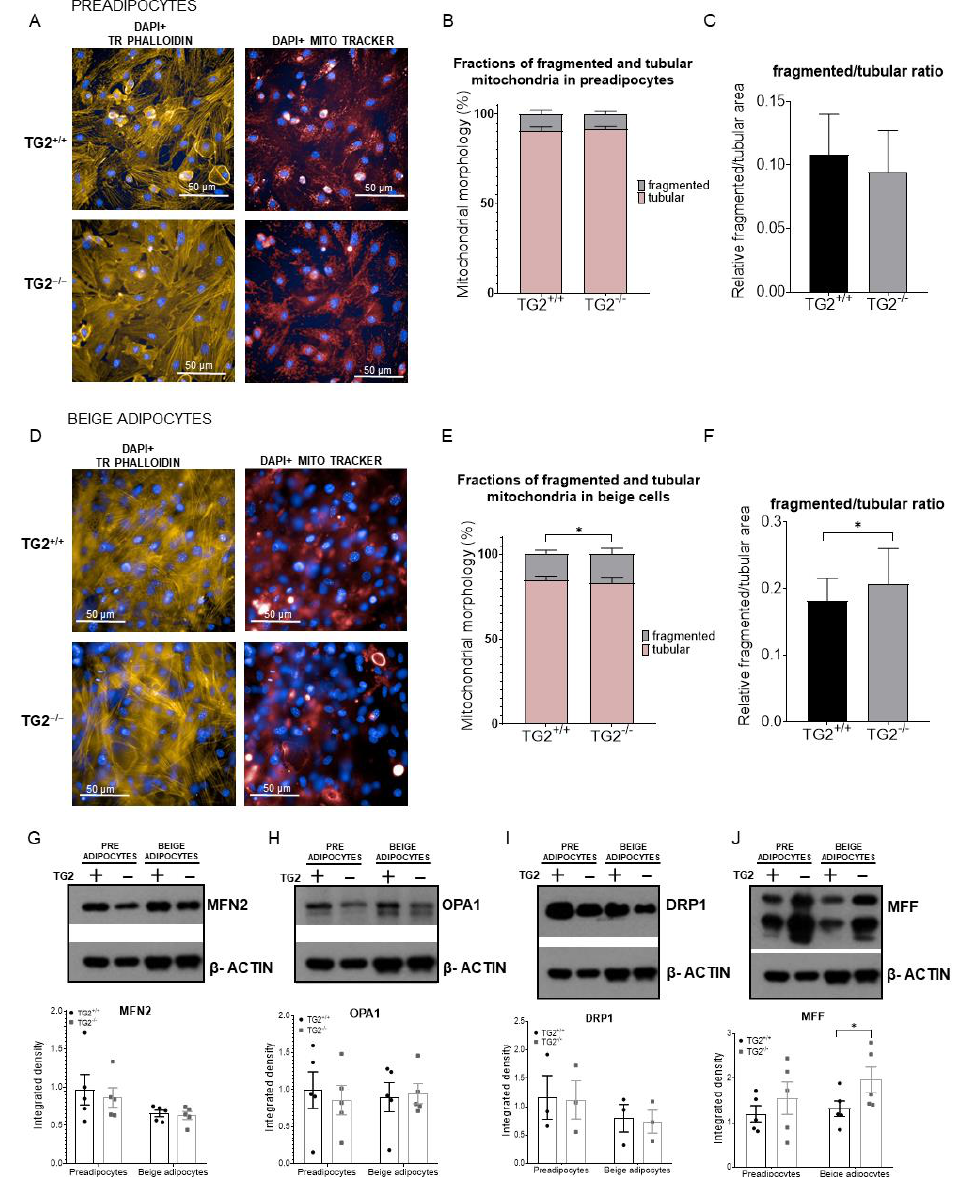
Figure 5. High content screening of the preadipocytes and beige cells, and detection of mitochondrial fission- and fusion-related proteins: ( A ) Representative high content screening images showing mitochondrial morphology in TG2 +/+ and TG2 − / − preadipocytes, scale bars represent 50 µ m; ( B ) fractions of fragmented and tubular mitochondrial morphology in preadipocytes (%); ( C ) quantitative analysis of mitochondrial morphology in preadipocytes; ( D ) representative high content screening images showing mitochondrial morphology in TG2 +/+ and TG2 − / − beige cells; ( E ) fractions of fragmented and tubular mitochondrial morphology in beige cells (%); ( F ) quantitative analysis of mitochondrial morphology in beige cells, DAPI staining was used to determine the number of nuclei, the mitochondria were stained with Mito Tracker Deep Red either in the absence or presence of 10 µ M antimycin A, Texas Red-X phalloidin was used to stain actin filaments for the detection of cell shapes ( n = 3); ( G – J ) representative Western blot analyses and quantitative analyses of the mitochondrial fusion proteins (MFN2, OPA1) and mitochondrial fission proteins (DRP1, MFF) in preadipocytes and differentiated beige cells. β -ACTIN was used as a loading control. Columns represent the mean values ± SD. Statistical analyses were performed using Student’s t -test. n = 5. * p < 0.05.